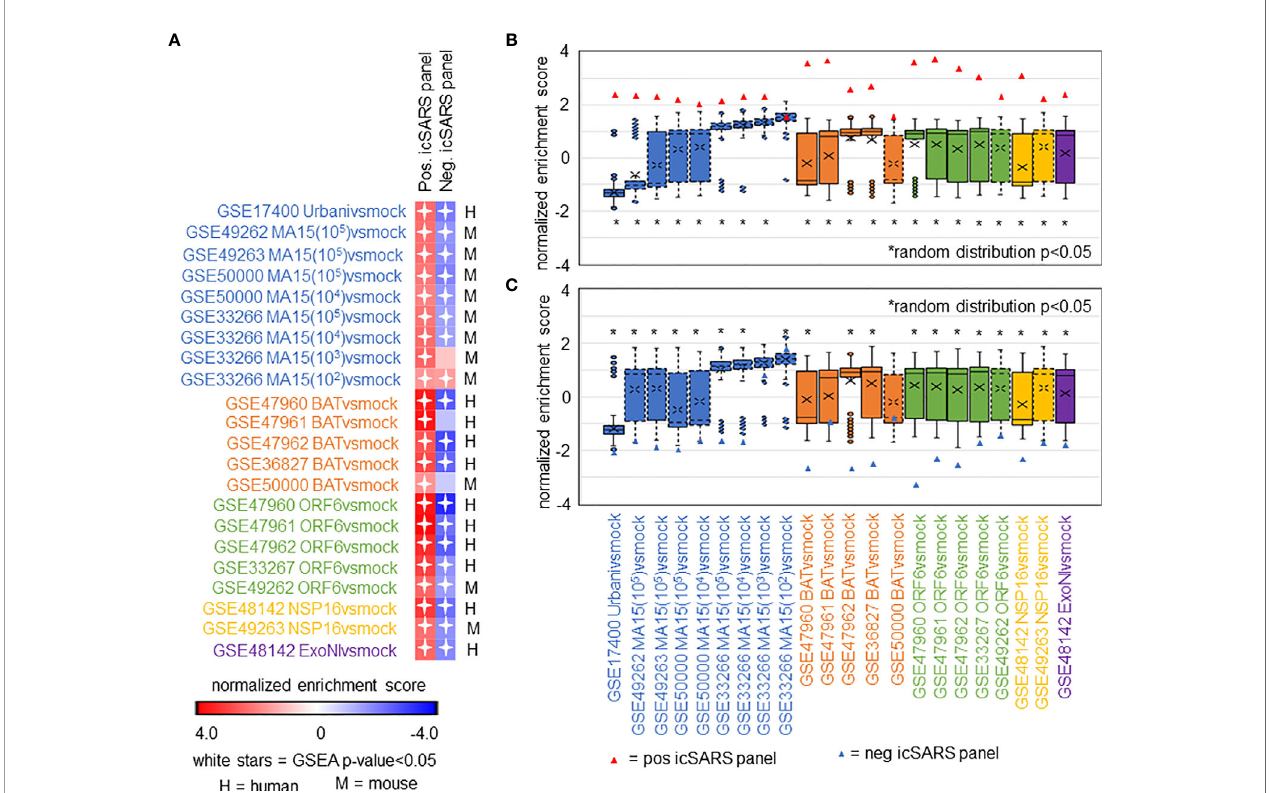
FIGURE 4 | icSARS Panel Enrichment Detected Differential Gene Expression Similarities Across SARS Strains with Varying Virulen. (A) Heat map of Gene Set Enrichment Analysis (GSEA) calculated normalized enrichment scores (NES) of the positive and negative icSARS panels across SARS-CoV strains with varying levels of virulence in both human lung cultures and mouse lung samples. (B) Box and whisker plots of NES from 1000 randomly generated gene panels containing 233 genes (individual queries) compared to gene signatures (individual references) used in (A) . (C) Box and whisker plots of NES from 1000 randomly generated gene panels containing 114 genes (individual queries) compared to gene signatures (individual references) used in (A)